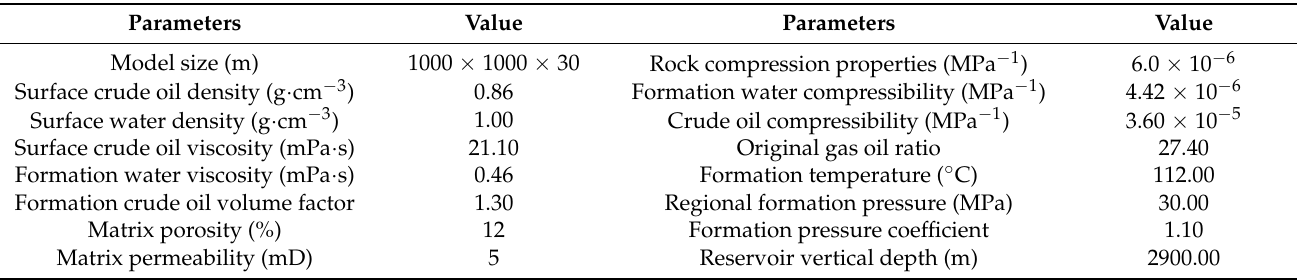
Figure 6. Matrix oil–water phase permeability ( a ) and capillary pressure curves ( b ). Table 4. Reservoir geological parameters.